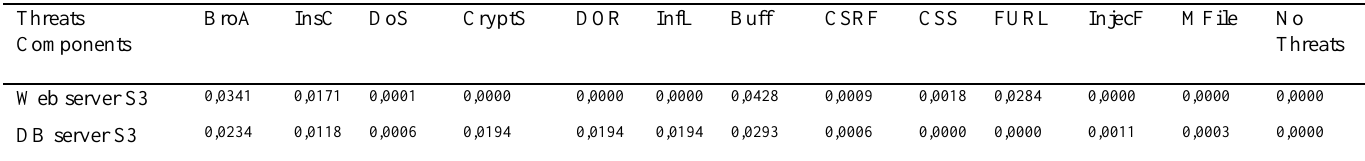
Table 9: The Impact Matrix S4 (IM